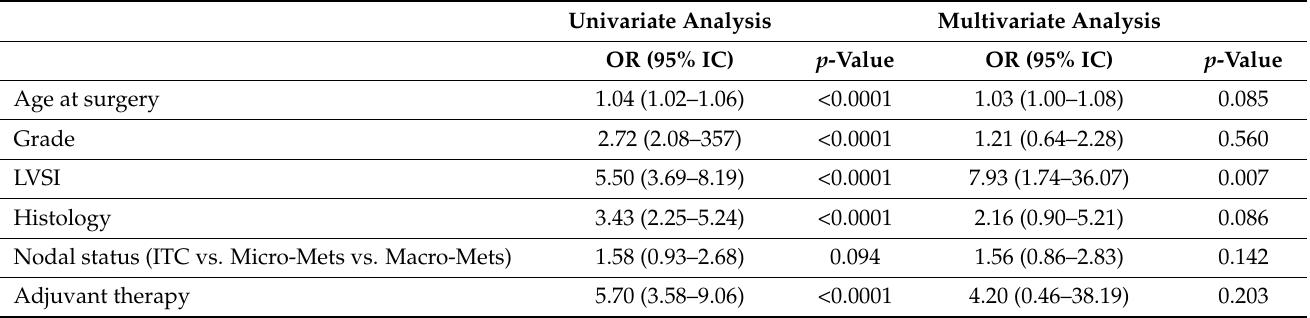
Figure 1. Kaplan–Meier plot of disease-free survival by the nodal status of lymph nodes. (N = 1428) Group 1 (black): negative; Group 2 (red dashed): isolated tumor cells; Group 3 (blue): micrometas- tases; Group 4 (green dashed): macrometastases. Table 3. Univariate and multivariate analysis on the risk of